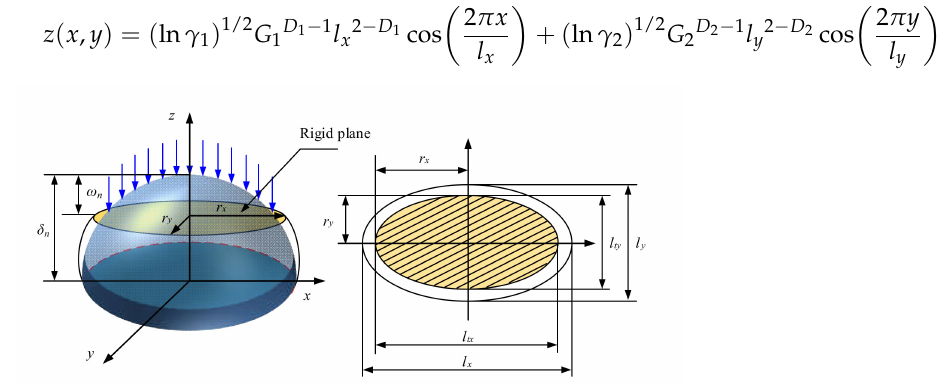
Figure 3. The contact model between a rigid plane and elliptical asperity.